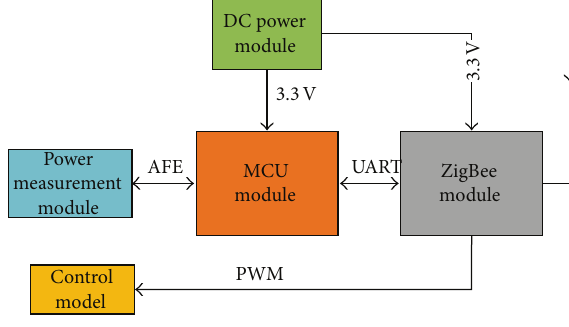
Figure 4: Block diagram of the sensor